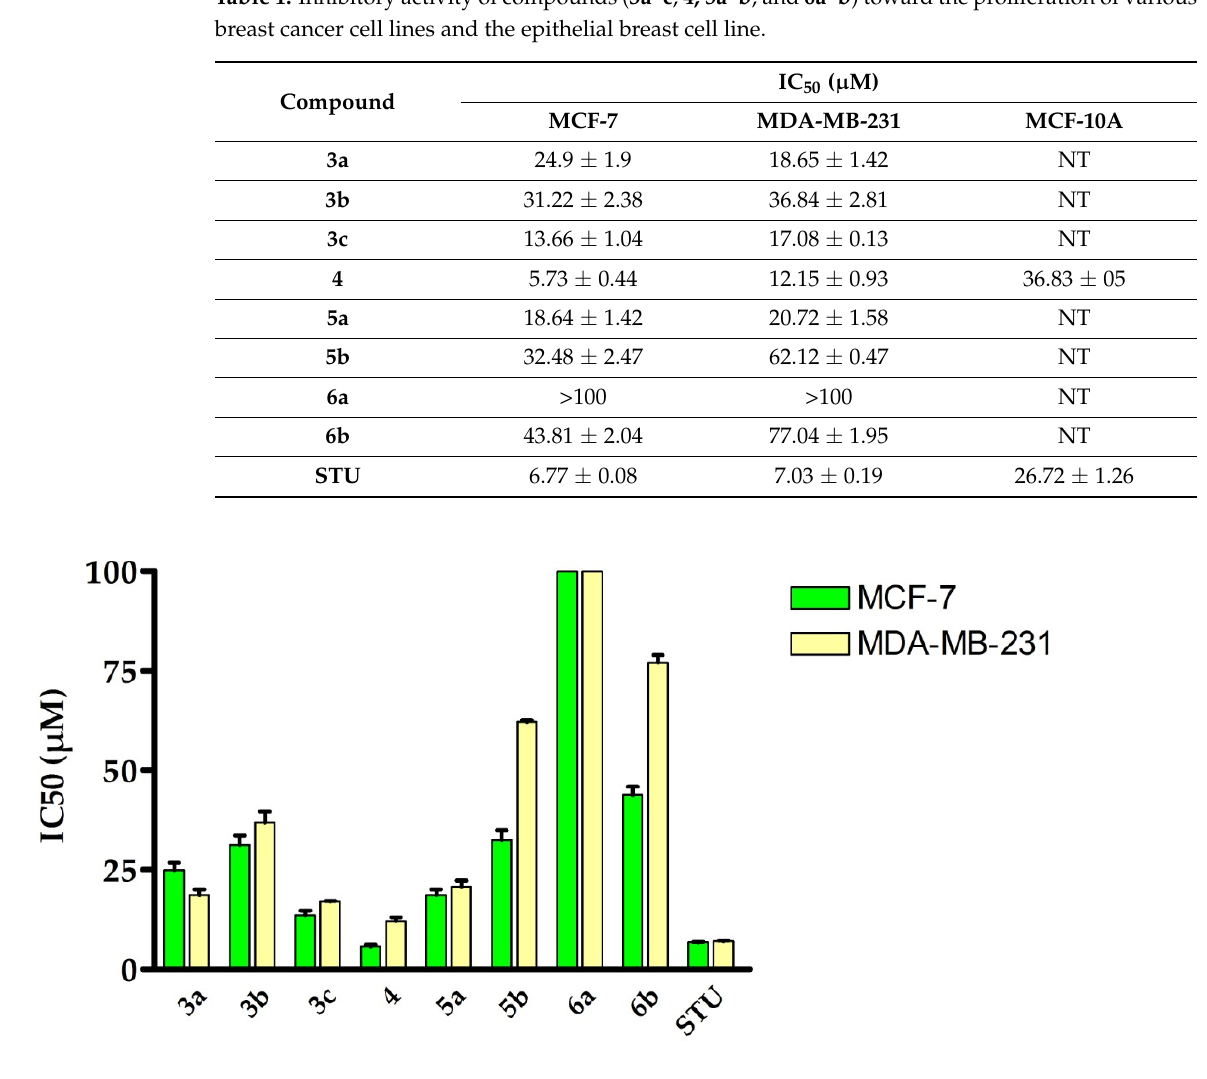
Figure 4. Representative diagram of the anti-proliferative activity of synthesized compounds toward the MCF-7 and MDA-MB-231 breast cancer cell lines.